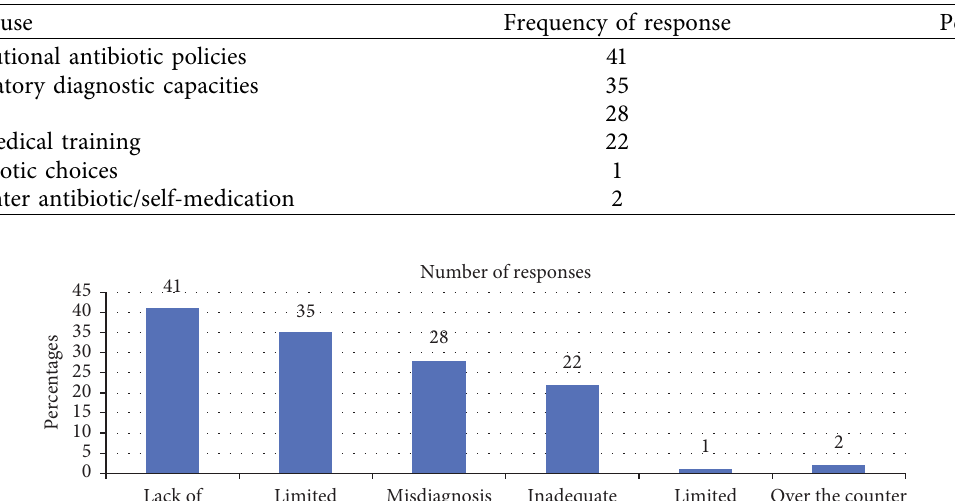
Table 5: Assessment of causes of ceftriaxone misuse.